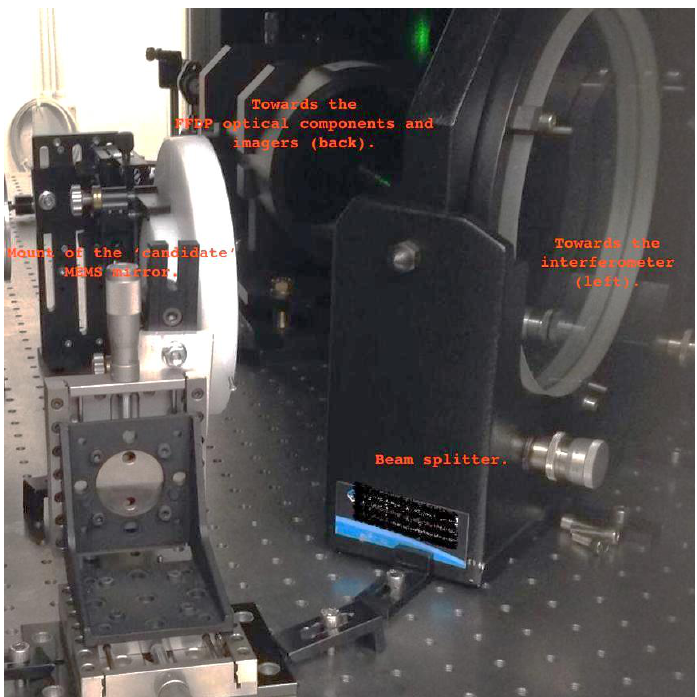
Figure 12. Excerpt of the mirror positioning on the optical bench. Table 1. Measured sample 1 mirror sample optical features.